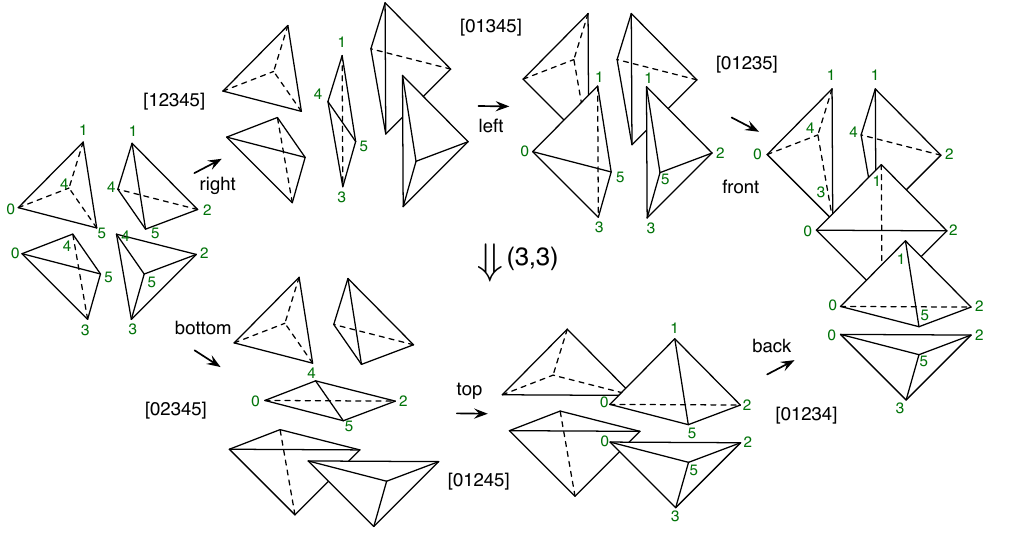
Figure 3 . The (3,3) Pachner move, interpreted as relation between sequences of (2,3) and (3,2)